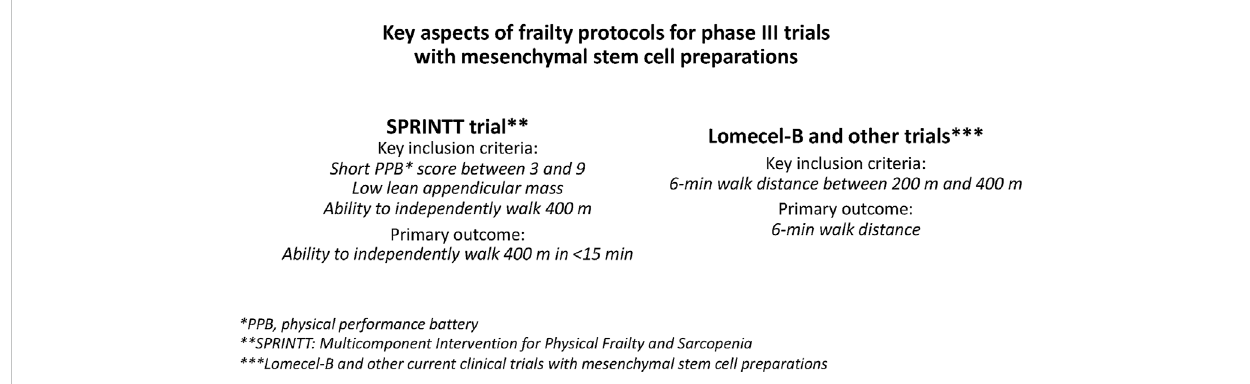
FIGURE 3 Key aspects of physical frailty protocols for phase III trials with mesenchymal stem cell (MSC) preparations. Two study protocols appear suitable for conducting phase III RCTs for aging frailty: (i) SPRINTT (Multicomponent Intervention for Physical Frailty and Sarcopenia) (Marzetti et al., 2018; Bernabei et al., 2022) and (ii) that used by ongoing clinical trials for aging frailty.